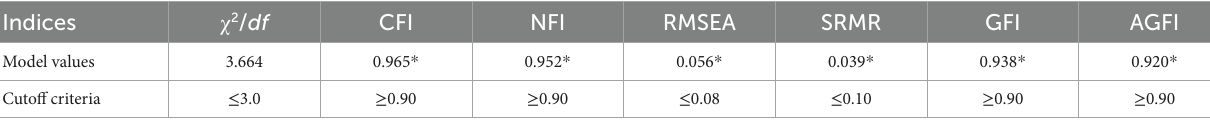
TABLE 4 Model fit indices of model